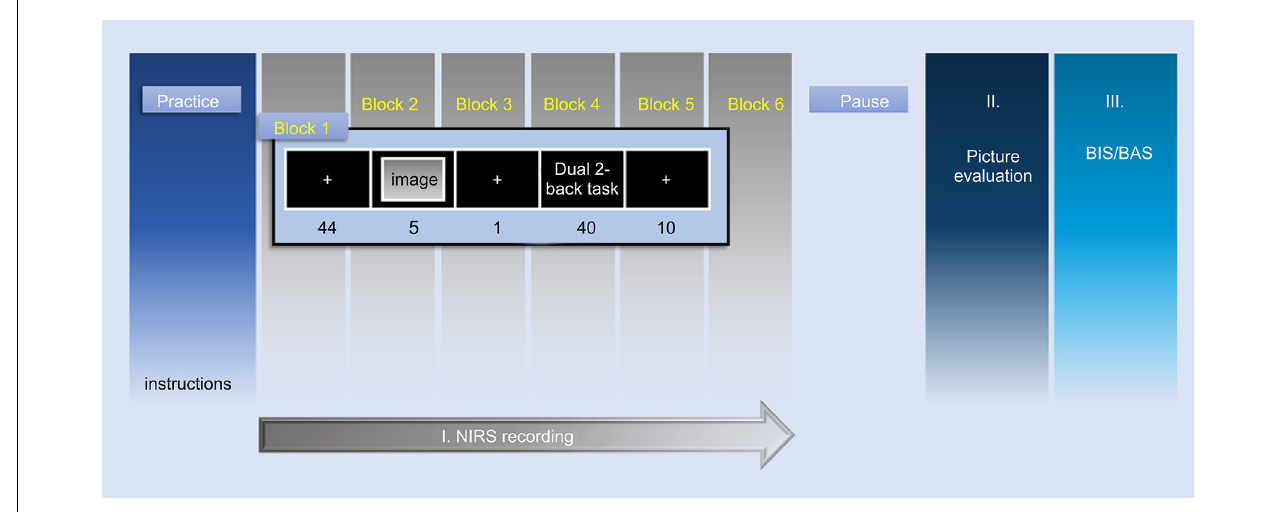
FIGURE 3 | Representation of the time course of the experimental protocol. This study consisted of the following three phases; I: NIRS-recording phase, II: Image-evaluation phase, III: BIS/BAS-scale phase. Phase I shows the NIRS measurement by block design. NIRS measurement was performed in six blocks according to the number of emotional images presented to each participant (two images for every emotional valence condition, six images in total). NIRS, near-infrared spectroscopy; BIS, behavioral inhibition system; BAS, behavioral activation